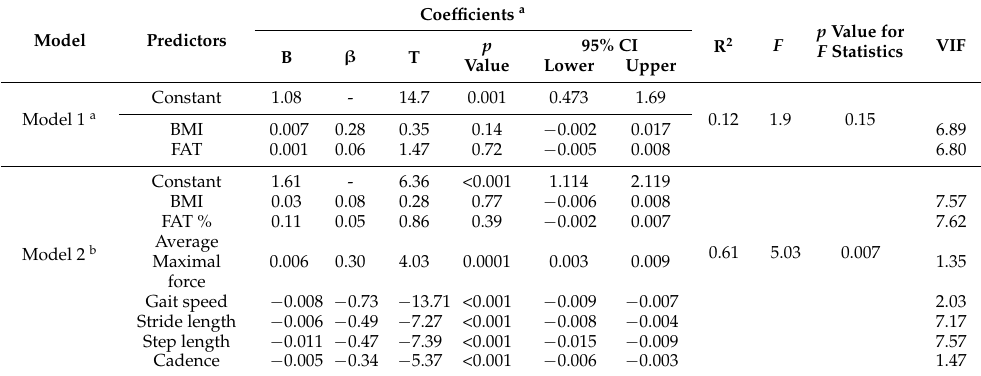
Table 5. Multiple linear regression analysis for performance fatigability as a dependent